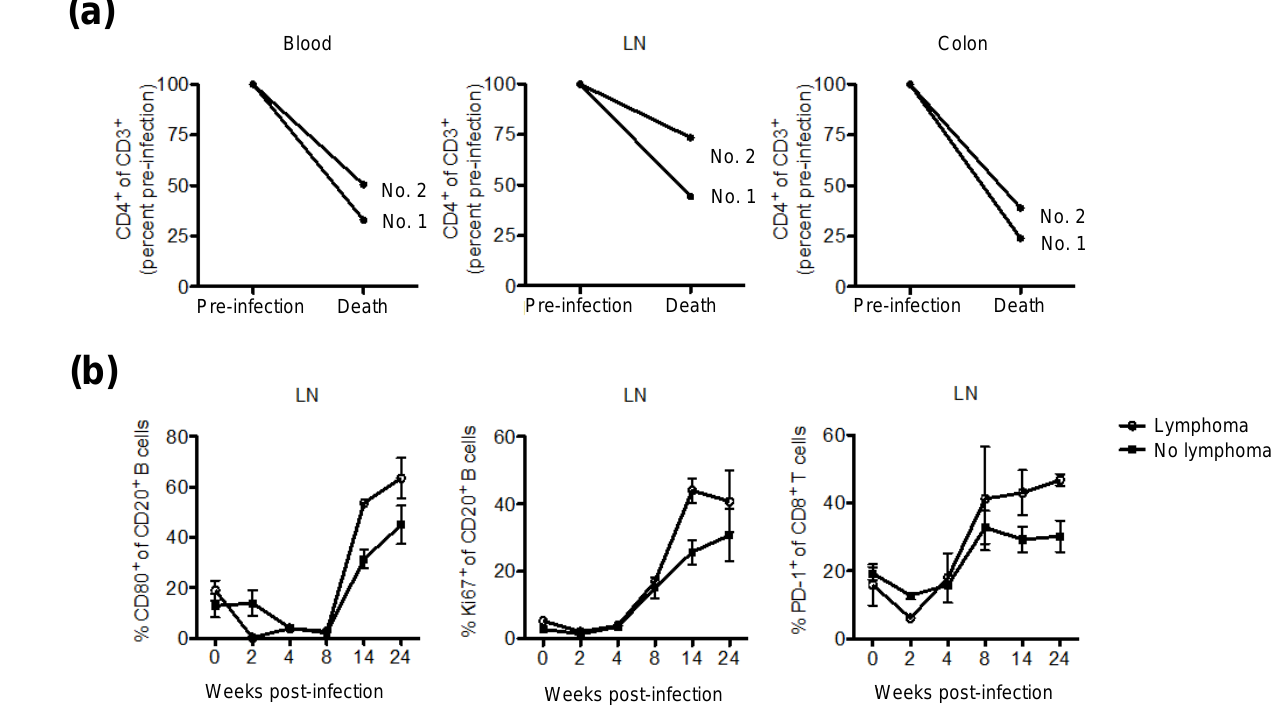
Figure 2. Percentages of T helper cell populations in blood as well as lymphoid and mucosal tissue of the two lymphoma case reports and those of activated lymph node B and T cells compared with animals infected with SIV concurrently but without development of lymphoma over time. (a) Proportion of CD4 + T cells of CD3 + cells normalized to pre-infection values in blood, lymph node and colon determined shortly before or at death (upper row). In each graph individual animal values designated nos. 1 and 2 and indicating the lymphoma case reports are shown. Pre-infection values of blood represent the mean of four independent measurements. For lymph node analysis one baseline value was available from a complete lymph node. Baseline values of the colon represent the mean of two independent analyses. (b) Longitu- dinal analysis of percentages of CD80 + and Ki67 + B cells, as well as PD-1 + CD8 + T cells in lymph nodes. Values from the two case report animals were compared with those from seven animals simultaneously infected with SIV. Post-infection measurements were conducted either with cells from whole lymph node at weeks 2 and 24 or with FNA cells at the other time points indicated. Pre-infection indicates values raised before infection; LN, lymph